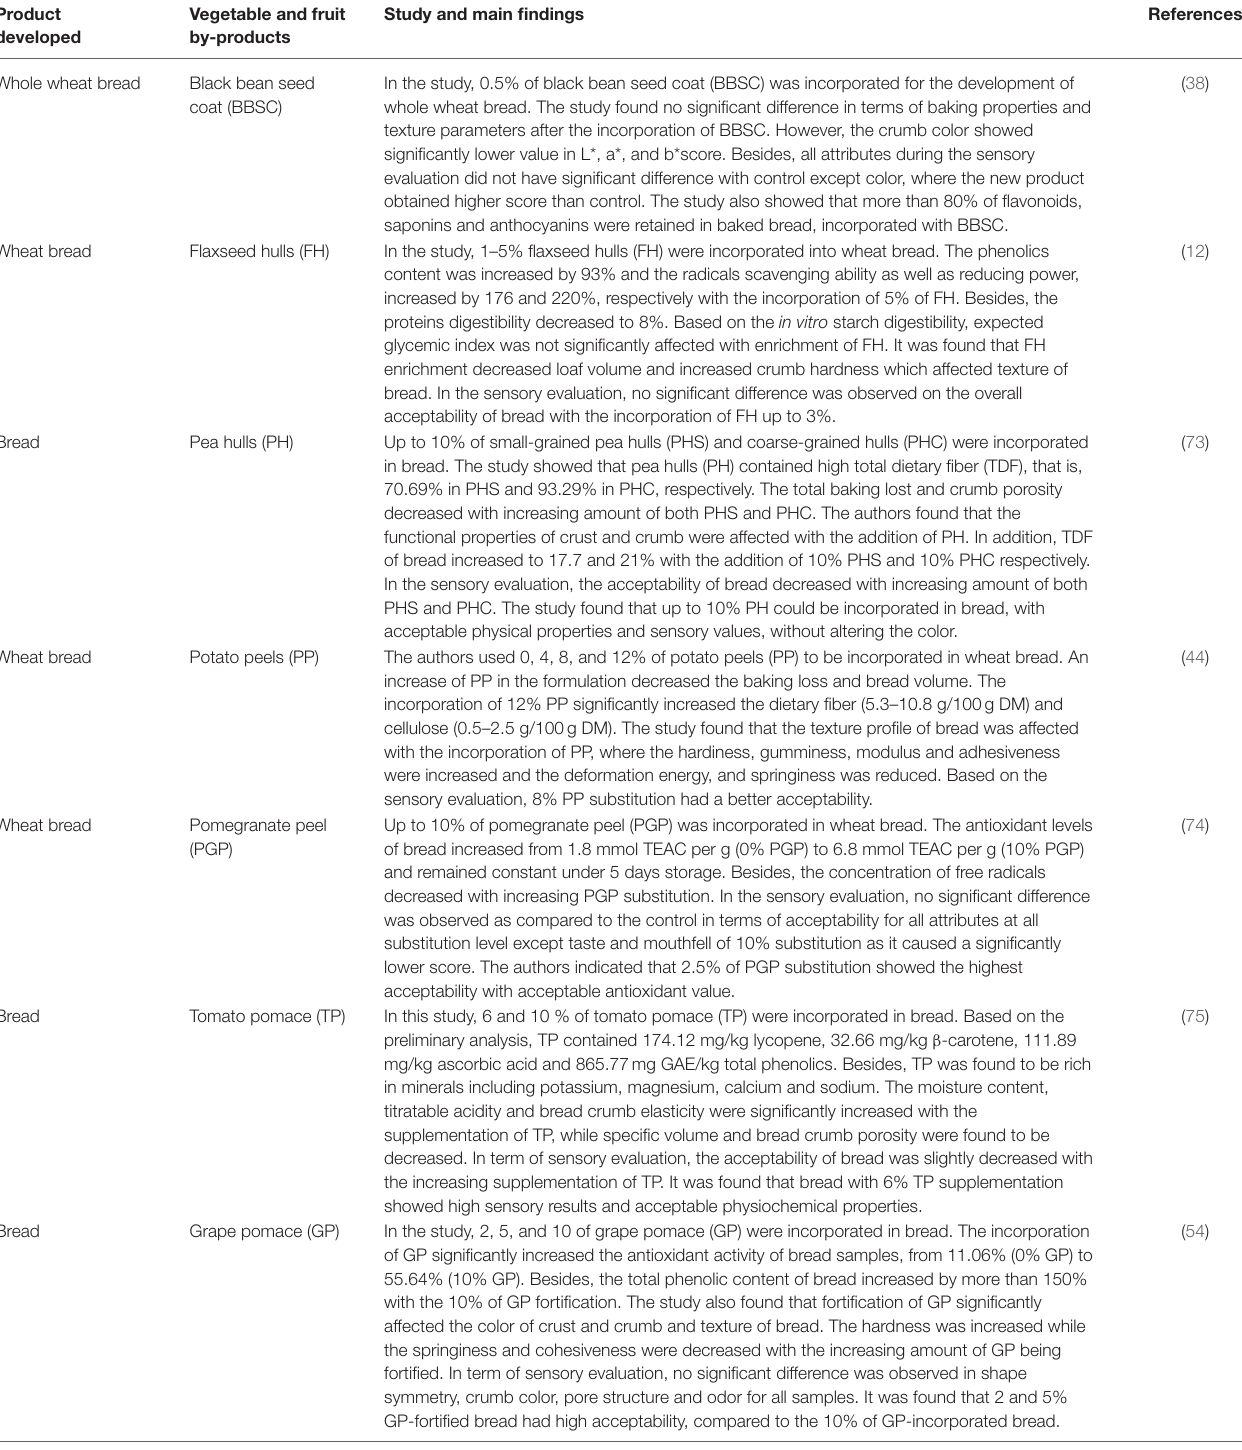
protein, and minerals (76). The incorporation of vegetable